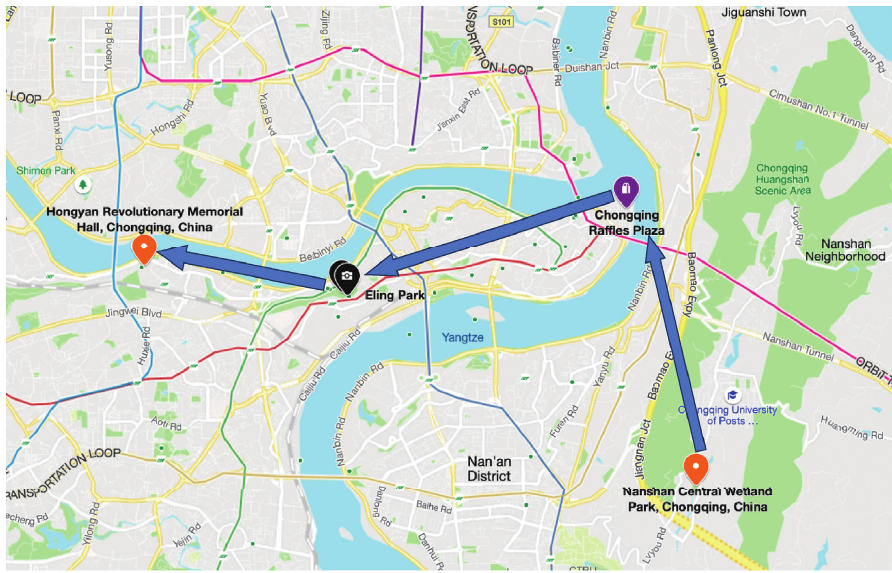
Figure 3: Example of city travel event sequence.